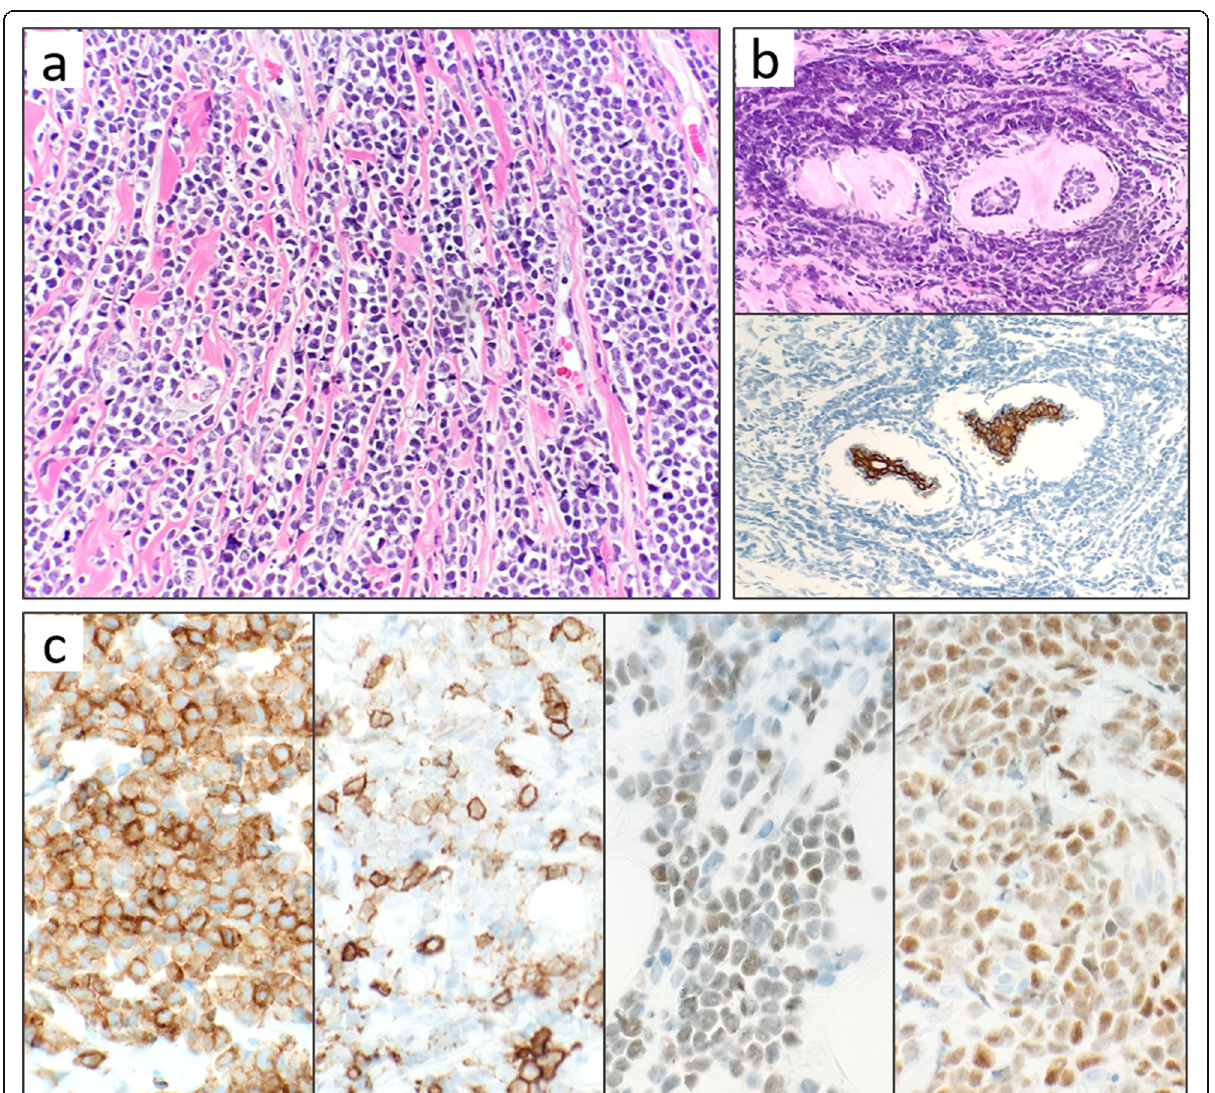
Fig. 2 Histopathologic findings of surgical biopsy specimen. a Atypical lymphoid cells with irregular nuclear membranes diffusely infiltrate the breast tissue. Cell discohesiveness is apparent, and tumor cells are in a linear pattern, resembling infiltrating lobular breast carcinoma. b Periductal infiltration was also observed (upper: hematoxylin and eosin staining). AE1/3 staining (lower), epithelial marker, was confirmed on normal breast ducts. c Immunohistochemical findings of CD20, CD10, TdT, and PAX5 (from the left to the